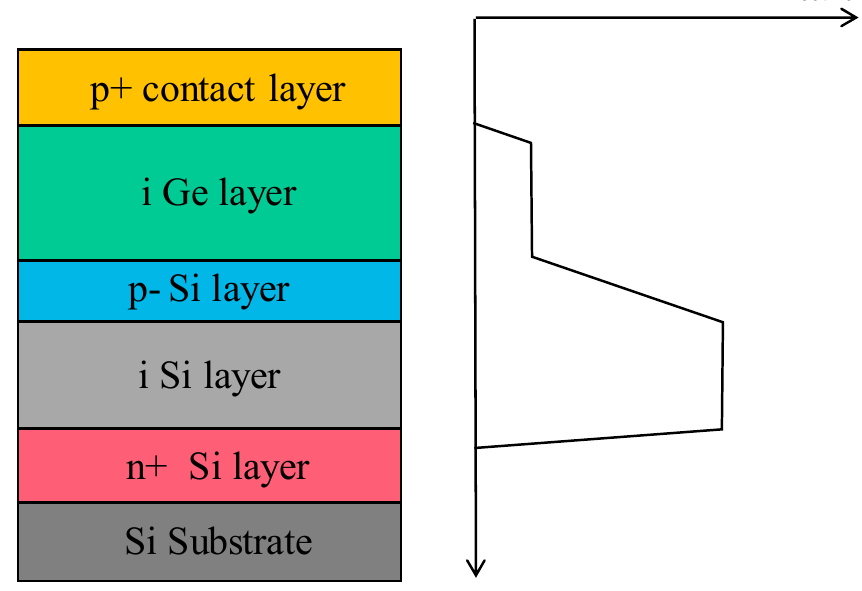
Figure 5. Schematic diagram and electric field distribution of SACM Ge/Si APD. For InGaAs/InP APDs, the schematic diagram and its electric field distribution were as follows (Figure 6) [37]. Schematic diagram and electric field distribution of InGaAs/InP APDs were shown in Figure 7 [37].